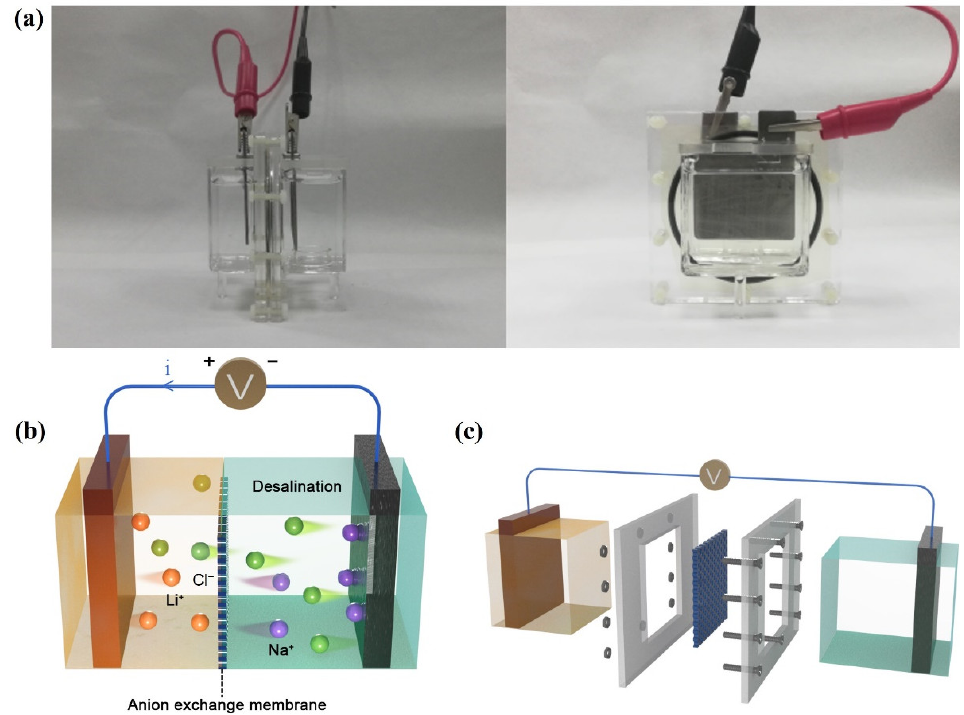
Figure 1. ( a ) Photographs of the CDI device; ( b ) the schematic illustration of the desalination pro- cess; and ( c ) the assembling of the desalination system. and ( c ) the assembling of the desalination